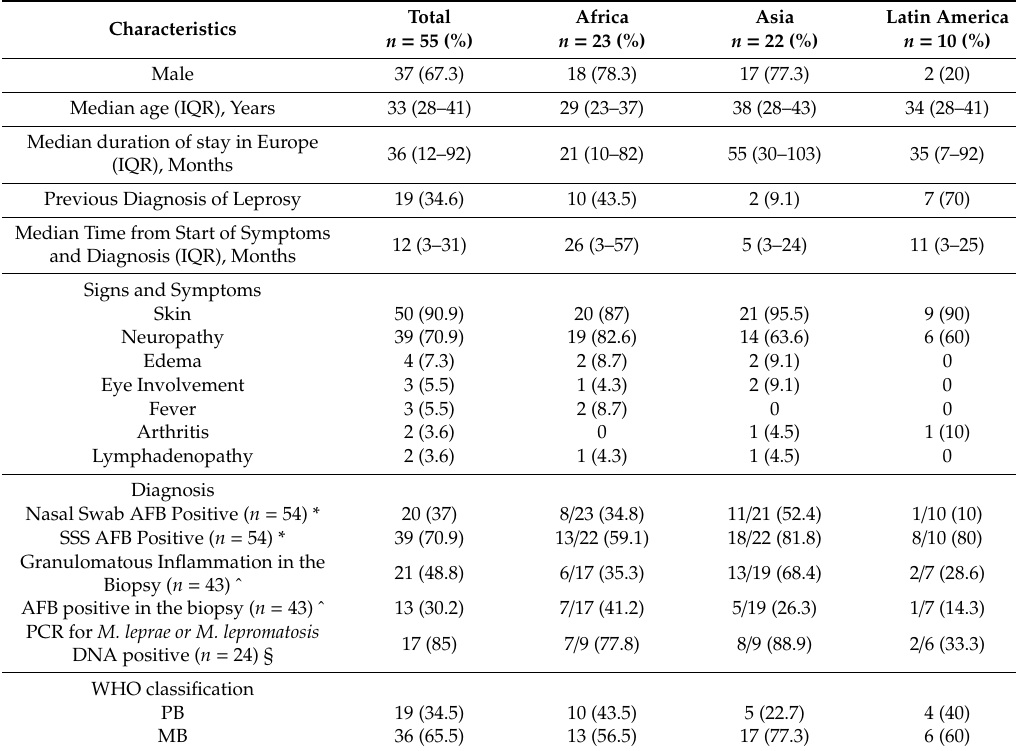
Table 1. Demographic, epidemiologic, and clinical characteristics of 55 migrants diagnosed with leprosy reported from 2009 to